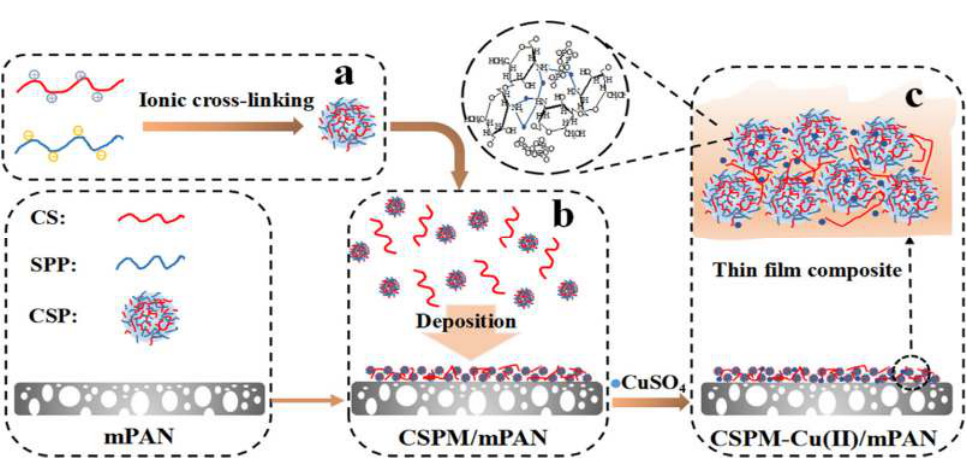
Figure 10. Diagrammatic sketch of membrane fabrication process of CSPM-Cu(II)/mPAN: ( a ) formation of CSPs, ( b ) deposition of CSP suspension onto mPAN to form CSPM/mPAN, ( c ) Cu(II) chelation of CSPM/mPAN to form CSPM- Cu(II)/mPAN. Extracted from [71].